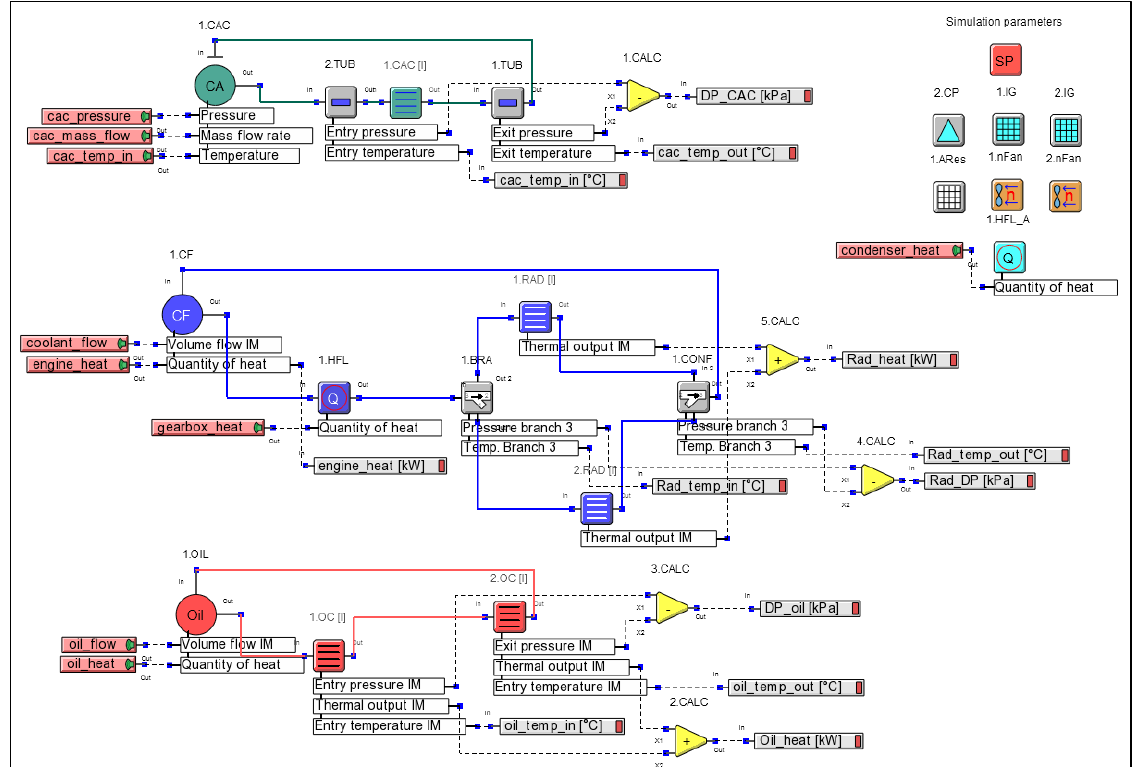
Fig. 1. 1D model of the cooling